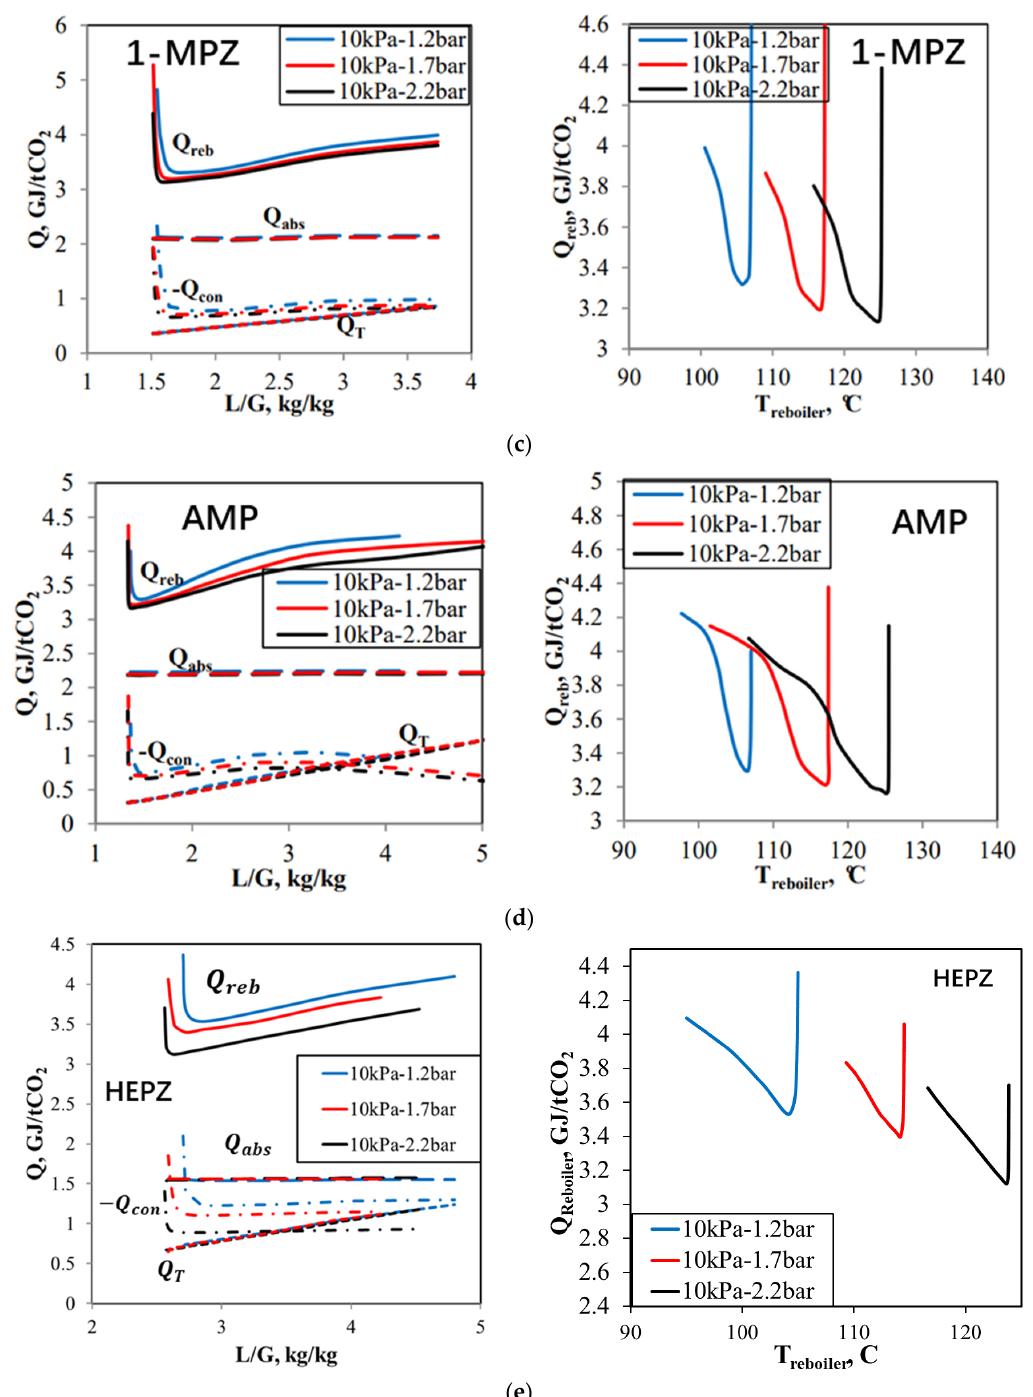
Figure 8. The effect of desorption tower pressure on reboiler energy consumption and reboiler temperature: ( a ) MEA, ( b ) DMEA, ( c ) 1-MPZ, ( d ) AMP and ( e ) HEPZ.